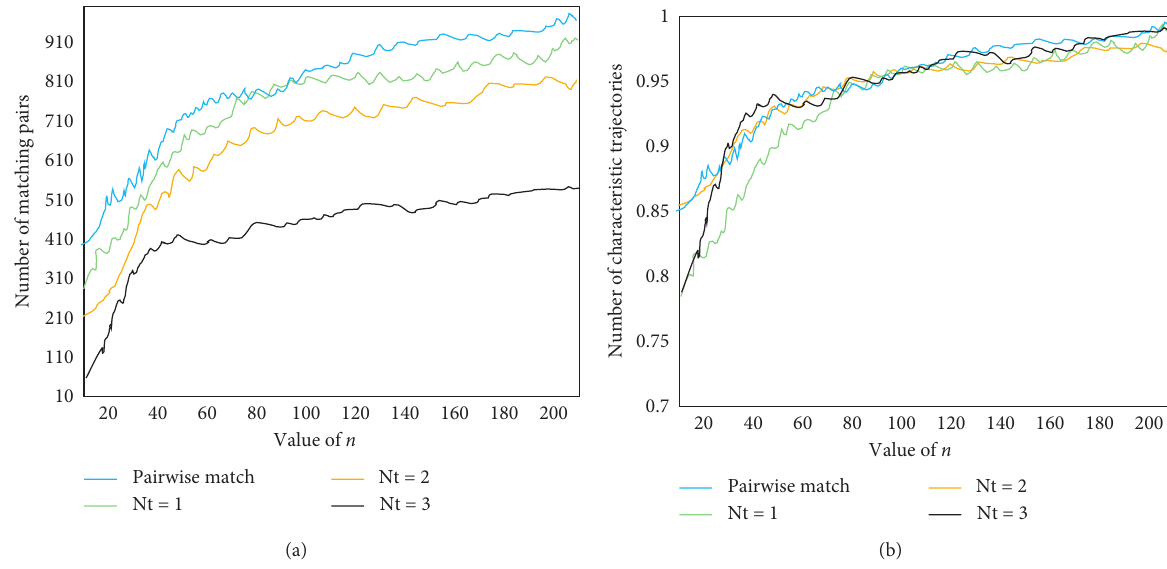
Figure 10: Test of multiview feature point matching under different number of images. (a) Number of image matching pairs. (b) Number of characteristic